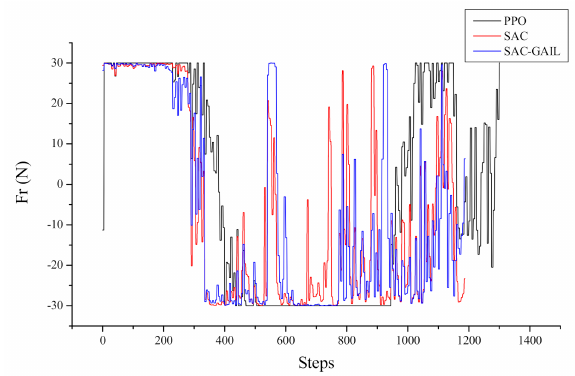
Figure 16. Curve of yaw moment output by AUV.